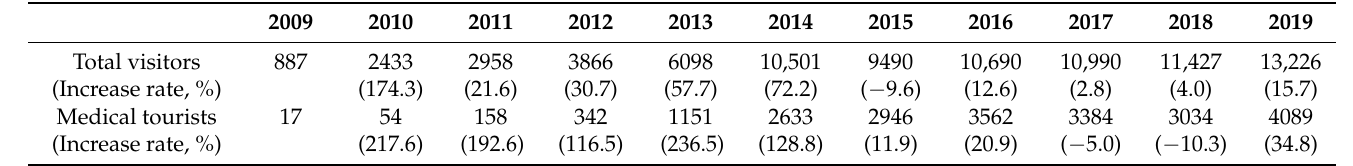
Table 7. The number of visitors and medical tourists from the